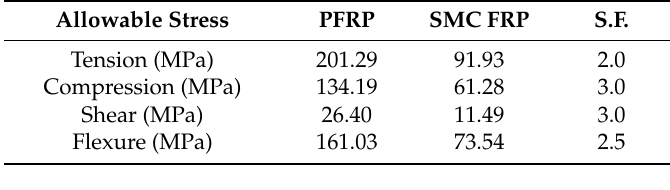
Table 3. Allowable stress.